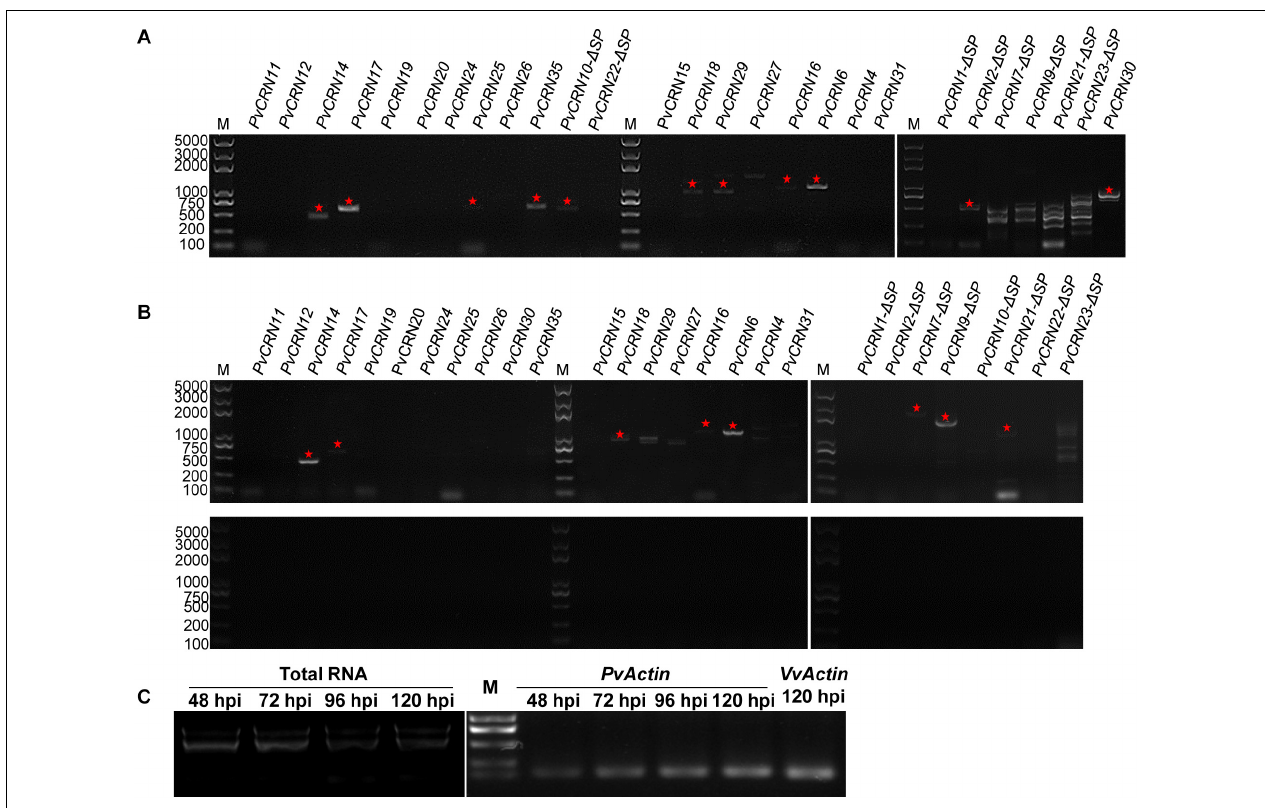
FIGURE 10 | Detection of the transcription level of PvCRN genes during infection of P. viticola YL on V. vinifera Pinot Noir by RT-PCR. (A) Transcriptional analysis of the PvCRN family in P. viticola YL sporangia 96 h post inoculation (96 hpi) on Pinot Noir leaves. The corresponding DNA band of each detectable PvCRN gene was marked with a pentagram. (B) Transcriptional analysis of PvCRN genes at 72 hpi (upper) and 120 hpi (lower). (C) Detection of the total RNA and cDNA prepared from Pinot Noir leaves inoculated with P. viticola YL. Experiments were repeated three times with similar